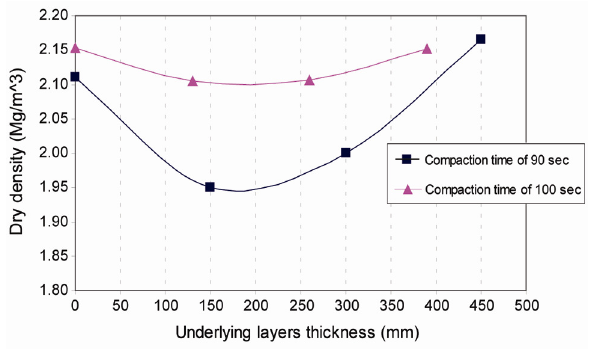
Fig. 9. Relationship between dry density of the upper layer and the thickness of underlying layers